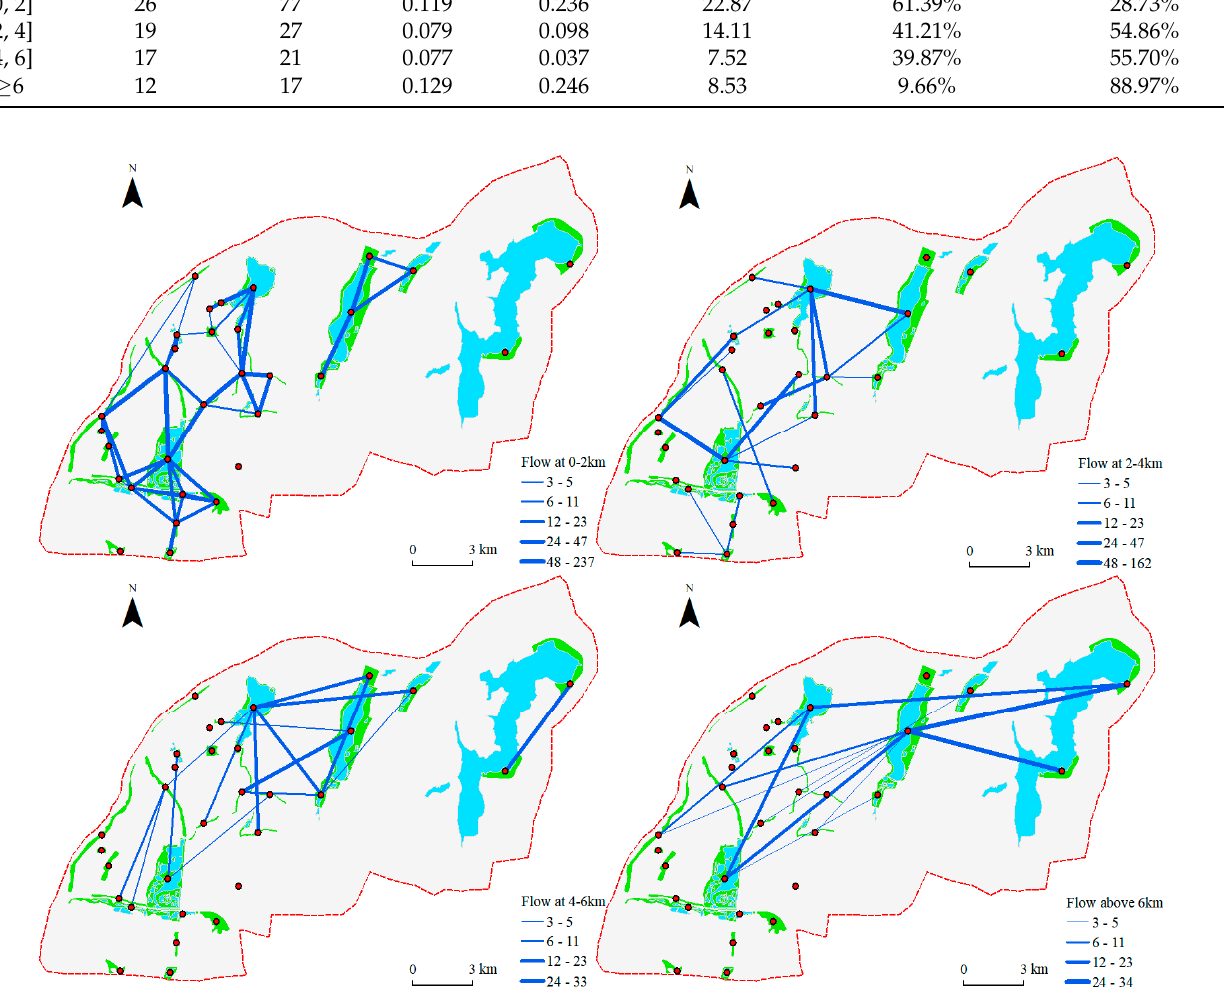
Figure 6. Spatial characteristics of the network under different distances. Table 4. Network characteristics under different